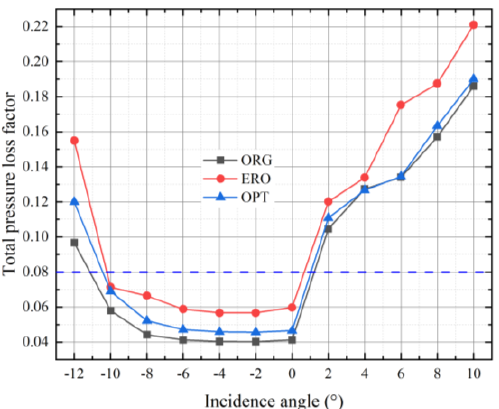
Figure 13. Comparison of the total pressure loss factors of original, eroded, and optimized blades.